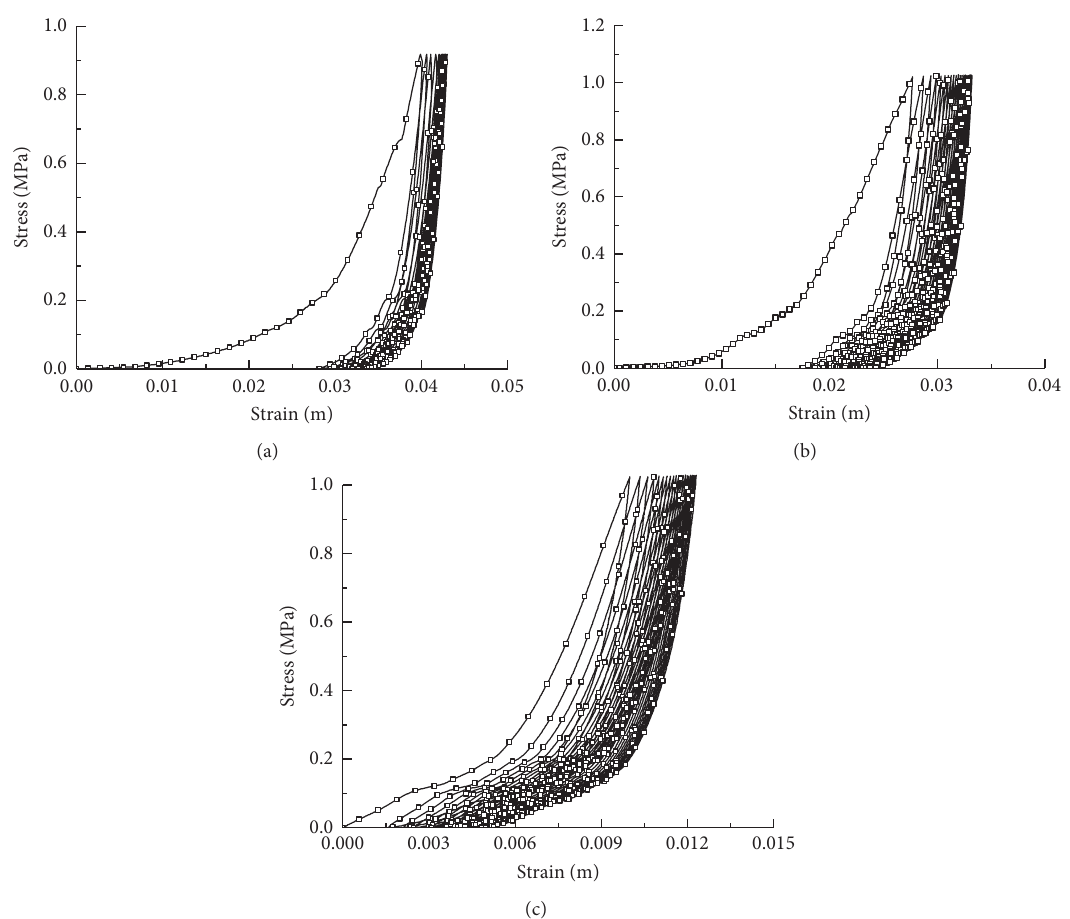
Figure 4: Stress-strain diagram of soil-rock mixture with moisture content � 14%. (a) Gradation 1. (b) Gradation 2. (c) Gradation